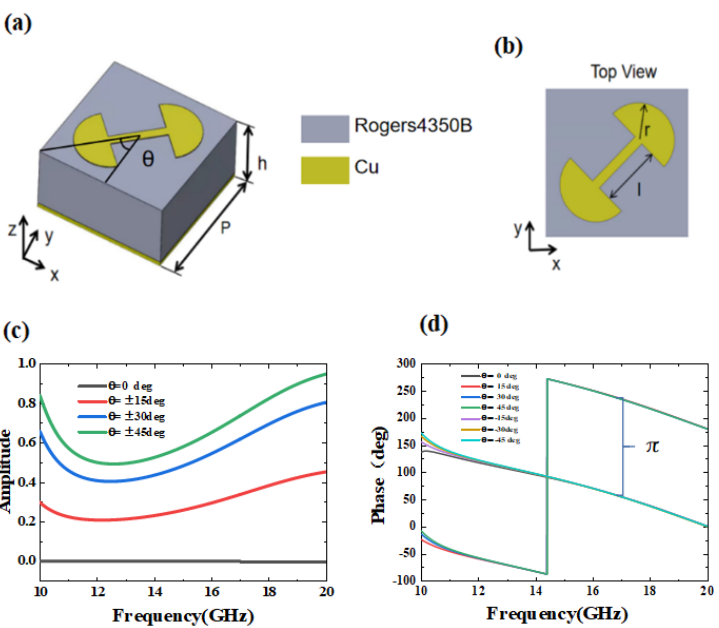
Figure 2. Cross-polarization transmission coefficient response of the designed dumbbell-type struc- tures: ( a ) a schematic of the dumbbell-type unit cell structure, ( b ) top views of the dumbbell-type unit cell, and ( c , d ) simulated cross-polarization transmission magnitude and phase performance of the dumbbell-type unit cell. The results are shown for different operating frequencies and as a function of the rotation angle.